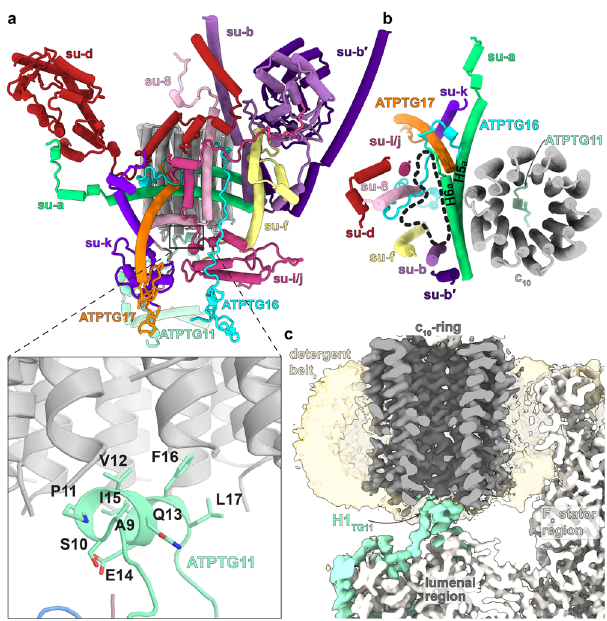
Fig. 2 Conserved and apicomplexan-speci fi c F o components of hexameric ATP synthase. a The canonical F o subunits b, d, f, i/j, k , and 8 contain apicomplexan-speci fi c extensions contributing to a large F o . Subunit- a contains only the conserved H5-6 a , and ATPTG16, ATPTG17 partially replace the missing H1-4 a . Inset shows N-terminal helix of ATPTG11 forming a parasite-speci fi c rotor-stator interface with the lumenal side of the c-ring. b Top view of rotor-stator interface. The absence of H1-4 a separates subunit- a from several canonical F o -subunits. Resulting lipid- fi lled F o void outlined (black dash). c Cross section through the F o region of the map. ATPTG11 extends from the lumenal region to plug the c-ring through interactions with H1 TG11 .